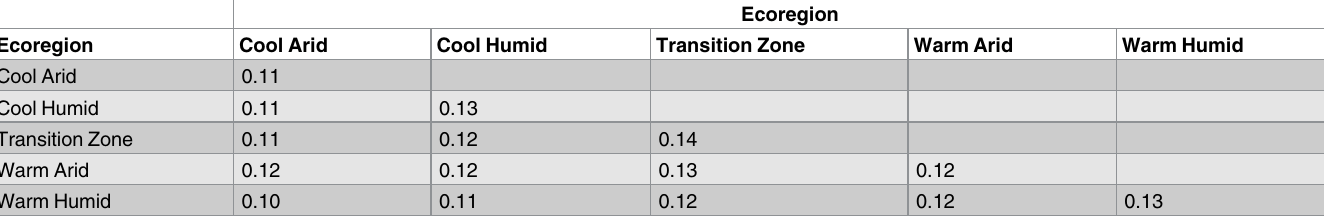
Table 2. Coefficients of genetic relationship within and among ecoregions without the Line 1 subpopulation.